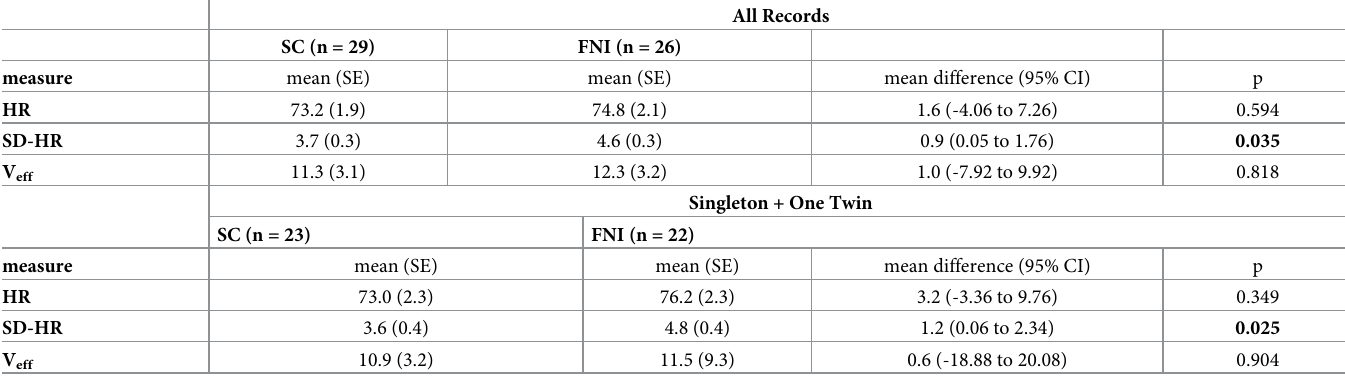
All Records FNI (n = 26)